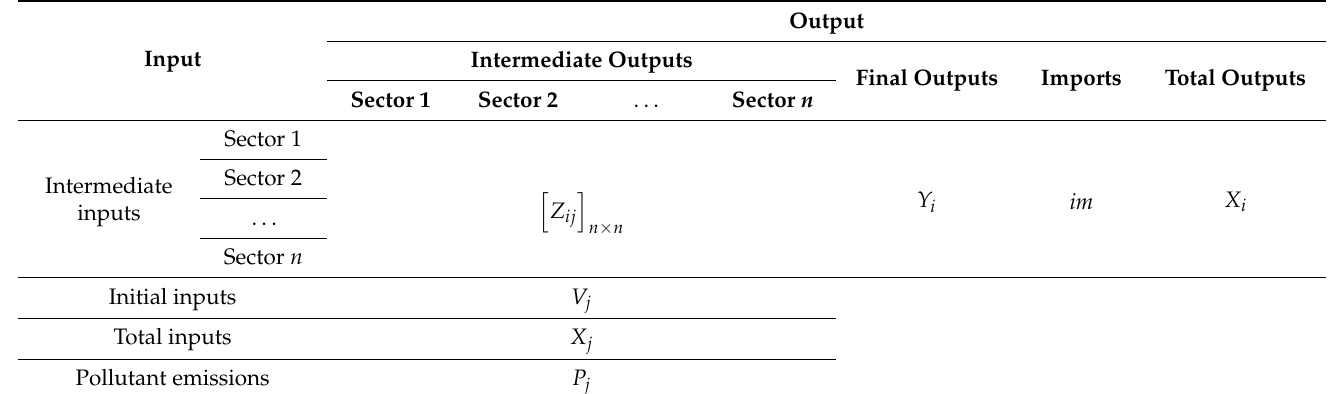
Table 1. Framework for environment extended input–output